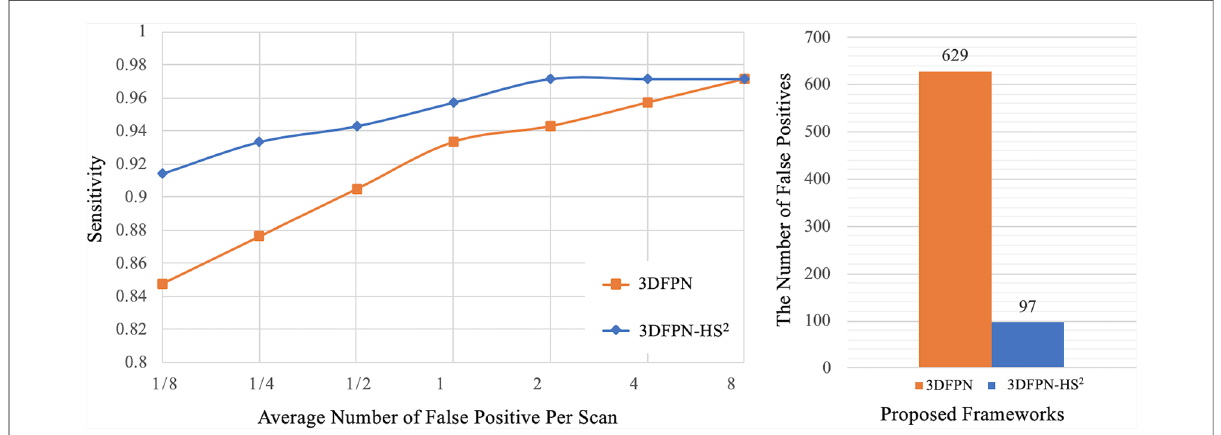
FIGURE 8 Comparison between the proposed 3DFPN and 3DFPN-HS 2 . Left: comparison of the proposed 3DFPN and 3DFPN-HS 2 on LUNA16 dataset without using the pre-trained model. 3DFPN-HS 2 greatly improves the performance of the 3DFPN at all FP levels per scan. Right: the number of false positives reduced from 629 to 97 for a total of 88 CT scans with the con fi dence score above 0 after applying the HS 2